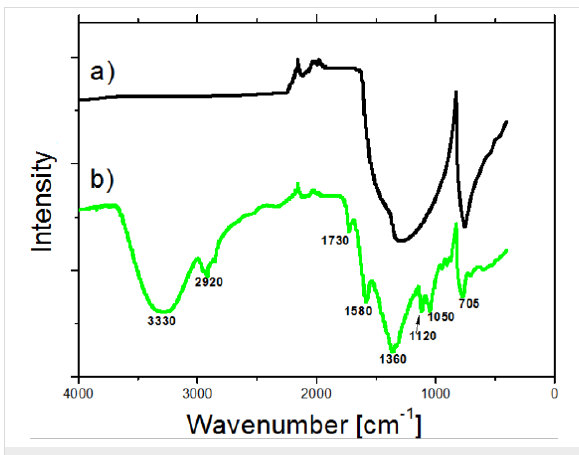
Figure 3: FTIR spectrum of pure BNNT (a) and P(AA- co -FA)-functio- nalized BNNTs (b).